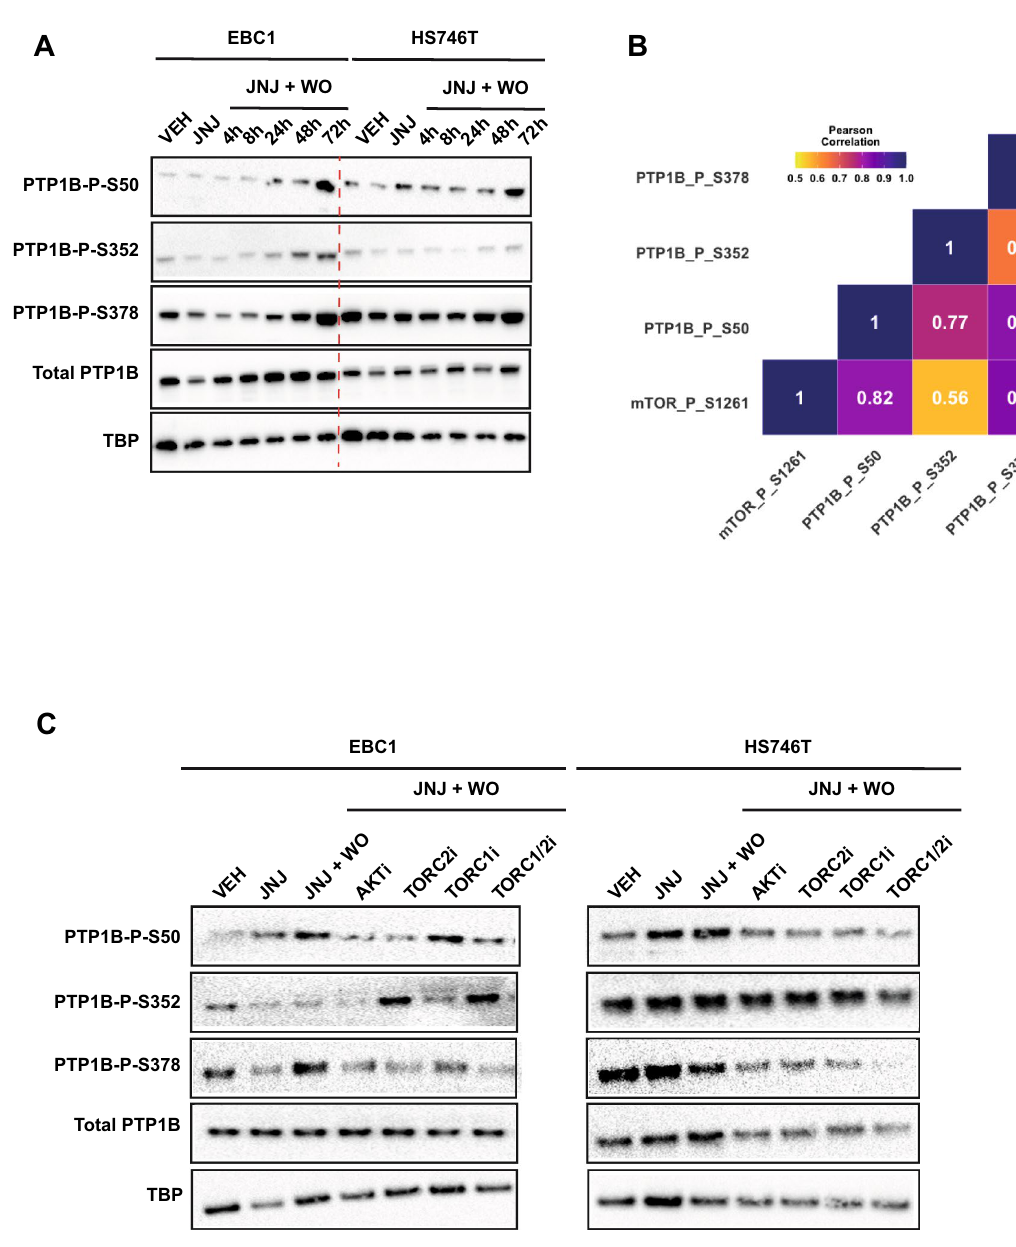
Figure 3. AKT/MTOR axis inactivates PTP1B and drives the flare effect. ( A ) EBC1 and HS746T cell lines were treated ON with JNJ-605 or DMSO (VEH). Following inhibitor withdrawal (WO), cells were harvested at the indicated time points (h). Total cellular lysates from the samples shown on top were immunoblotted, as indicated on the left. Black-edged rectangles delineate the blot. The dashed red vertical line highlights the separation between cell lines for clarity. ( B ) Correlation heatmap showing the relationship between mTOR activation and PTP1B phosphorylation in cancer patients (TCGA data, N = 42 patients). The colour code represents the Pearson correlation score. ( C ) Cells were treated ON with JNJ-605 or DMSO (VEH). After JNJ- 605 WO, 1uM of MK-2206 (AKTi), 1uM of JA-AB2-011 (mTORC2i), 0.1uM of rapamycin (mTORC1i), or 1uM of Temsirolimus (mTORC1/2i) were added in the culture medium. Cells were lysed for immunoblotting 48 h later. Black-edged rectangles delineate the